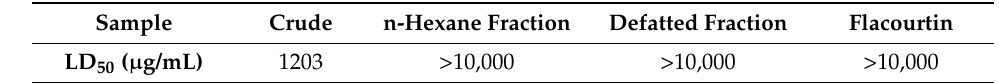
Table 1. Cytotoxicity of test samples.